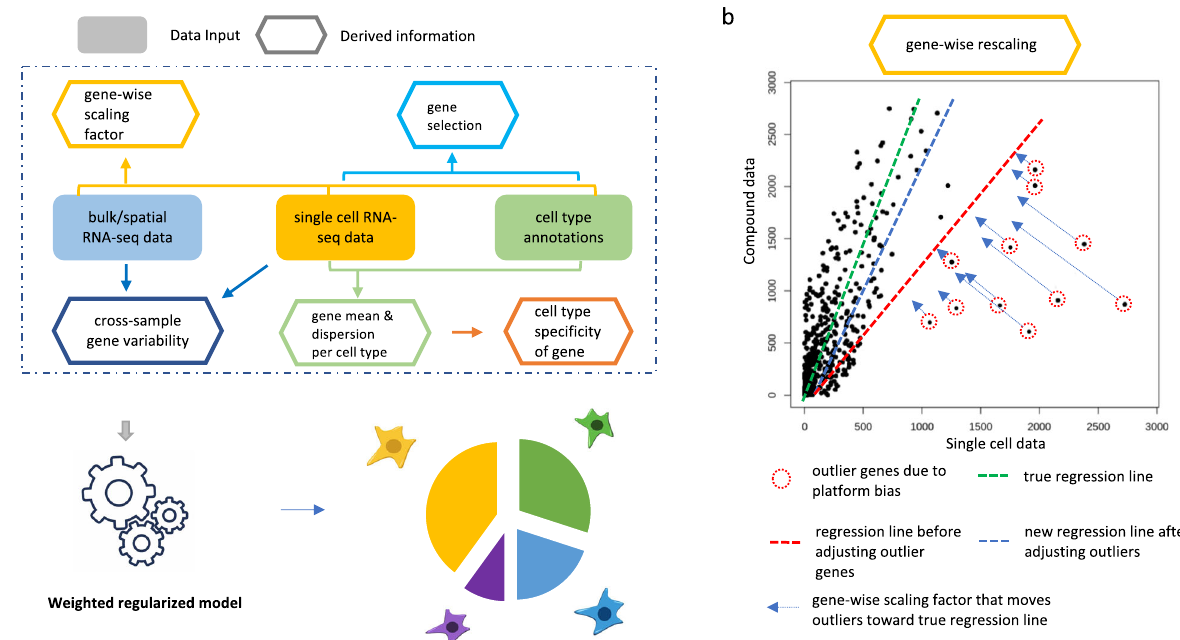
Fig. 1 Schematic representation of AdRoit computational framework. a AdRoit inputs compound (bulk or spatial) RNA-Seq data, single-cell RNA-Seq data, and cell type annotations. It fi rst selects informative genes and estimates their means and dispersions, then computes the cell type speci fi city of genes. Depending on the availability of multiple samples, cross-sample gene variability is derived from either the compound RNA-Seq, or the single-cell data (see also “ Methods ” ). Lastly the gene-wise correction factors are computed to reduce the platform bias between the compound and the single-cell RNA-Seq data. These quantities are used in a weighted regularized model to infer the cell type composition. b A mock example to illustrate the role of the gene-wise correction factor. Conceptually, an accurate estimation of the cell proportions should be represented by the slope of the green line; however, fi tting in the presence of outlier genes would result in the red line. Outlier genes exist because the platform bias affects genes differently. AdRoit adopts an adaptive learning approach that fi rst learns a coarse estimation of the slope (red line), from which the gene-wise corrections are derived and applied to the outlier genes, moving them toward the green line. The more deviated the gene, the larger the correction (i.e., longer arrows). After the adjustment, the new estimated slope (blue line) is closer to the truth (green line) and thus is a more accurate